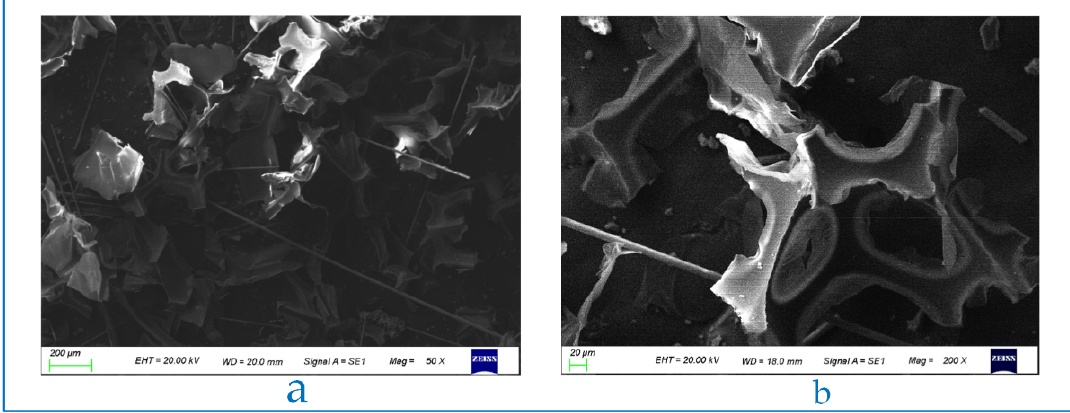
Figure 6. Microscopic morphology of PUF powder with different magnification. ( a ) 50 times ( b ) 200 times.